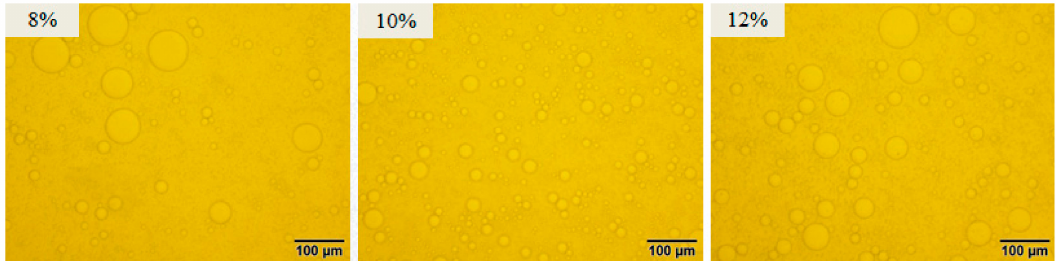
Figure 9. Optical micrographs of emulsions (50 vol% internal phase) stabilized by GNPs